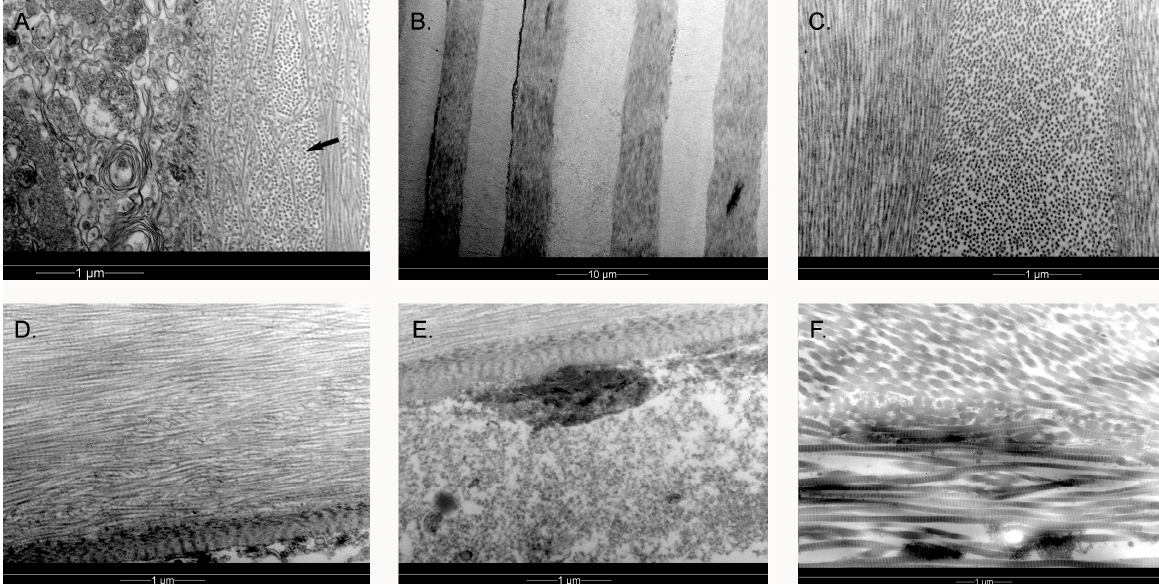
Figure 5. The right cornea of the gentoo penguin Pygoscelis papua G4, examined by transmission electron microscopy. ( A ) Anterior central cornea, showing extensive interdigitation between the col ‐ lagen fibrils in Bowmans’s layer (arrow). Unlike in the human Homo sapiens , the collagen fibrils of acellular Bowman’s layer did not appear much thinner than those of the stroma. The orientation of collagen fibres was either perpendicular to or parallel with the plane of section rather than in all directions. The epithelium in this specimen has been affected by post ‐ mortem changes; ( B ) Low magnification, central cornea; ( C ) High magnification, central stroma. Much more regular, thicker and orthogonal layers were visible in the mid and posterior stroma with thin keratocytes at the borders between bands, very similar to the king penguin Aptenodytes patagonicus ; ( D ) More periph ‐ eral posterior stroma and Descemet’s membrane, showing a slightly more irregular structure, espe ‐ cially close to Descemet’s membrane; ( E ) Higher powered view of Descemet’s membrane, with a small remnant of endothelium attached. Note the electron ‐ dense “nodes” forming faint stripes, thin ‐ ner than the human but similar in thickness to the little penguin Eudyptula minor ; ( F ) Peripheral stromal collagen fibrils were still organised into bands which are at 90° to their neighbours, although somewhat less regular in thickness and outline. The collagen fibrils were banded, as in the human, with variation in size. The larger fibrils were up to 90 nm in diameter.